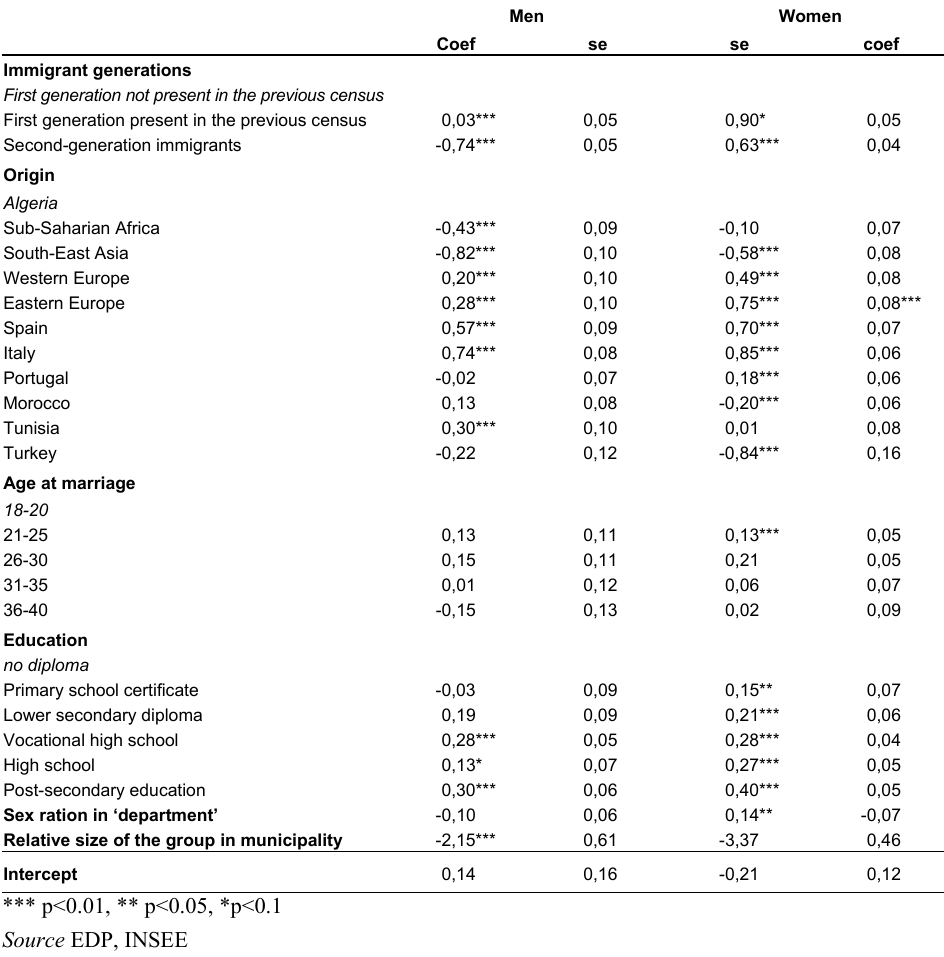
Table 5: Probability of marriage with a French spouse born in France for first- and second-generation immigrants (probit